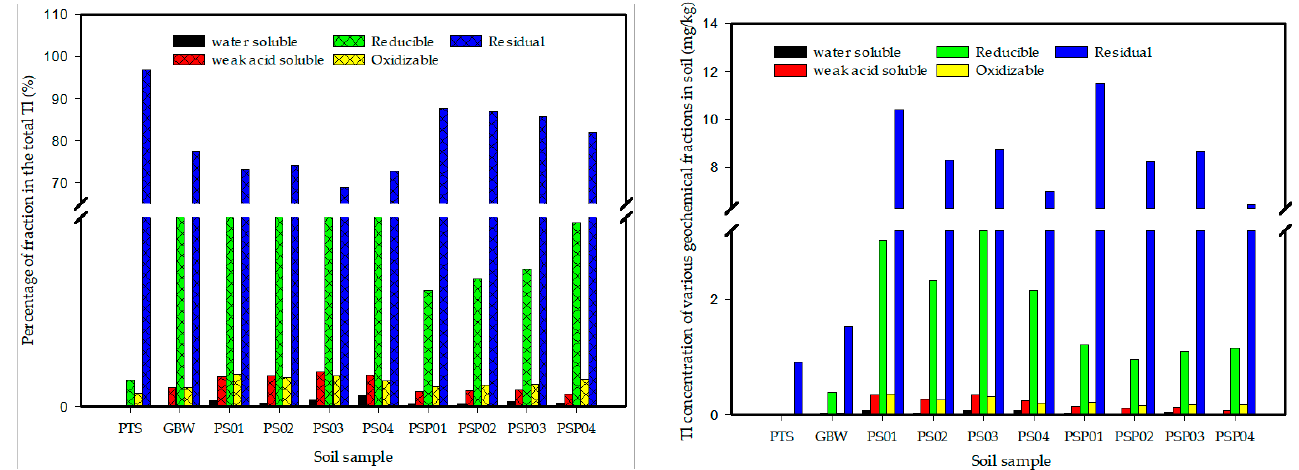
Figure 6. Tl existing in various fractions in soils, modified after [63]. PTS = Pot trial soils, GBW = GBW ‐ 07405, PS01 = 12 mg/kg Tl(I) treated, PS02 = 8 mg/kg Tl(III) treated, PS03 = 12 mg/kg Tl(I) + 3 g/kg Ca treated, PS04 = 8 mg/kg Tl(III) + 3 g/kg Ca treated, PSP01 = 12 mg/kg Tl(I) + Planted, PSP02 = 8 mg/kg Tl(III) + Planted, PSP03 = 12 mg/kg Tl(I) + 3 g/kg Ca + Planted, PSP04 = 8 mg/kg Tl(III) + 3 g/kg Ca + Planted.